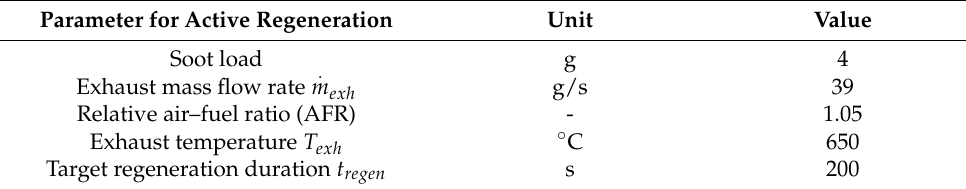
Table 9. Parameters used to simulate an active regeneration event on the burner test bench. Parameter for Active Regeneration